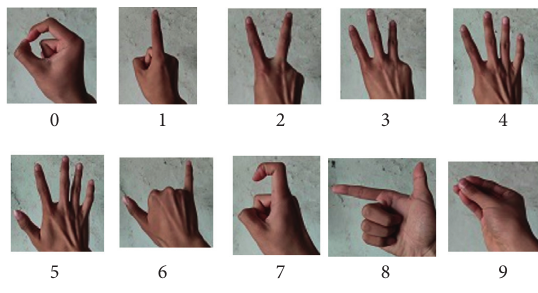
Figure 6: Gesture representation.